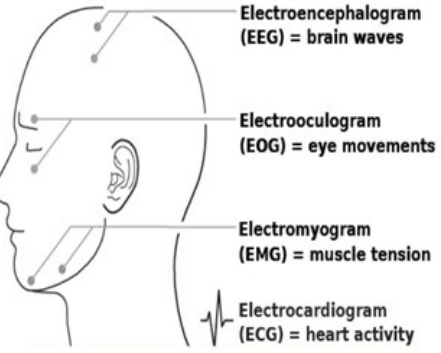
Figure 5. The physical distribution of drozy polysomnography signals on the driver’s head.